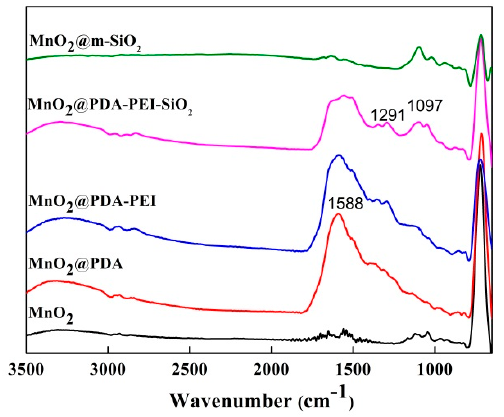
Figure 1. FTIR spectra of MnO 2 , MnO 2 @PDA, MnO 2 @PDA-PEI, MnO 2 @PDA-PEI-SiO 2 and MnO 2 @m-SiO 2 . PDA: polydopamine; PEI: polyethyleneimine